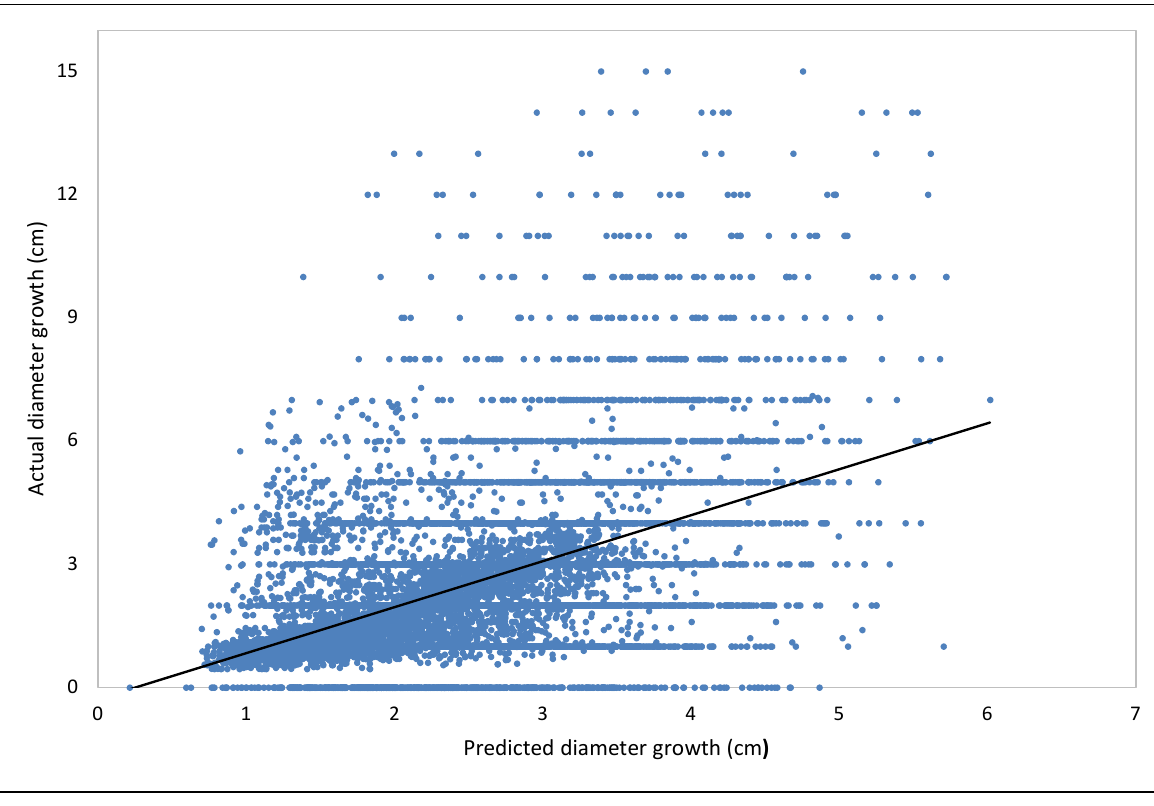
Figure 10. Relationship between predicted and actual diameter increment by mixed-effect regression (cm) affected by climate change. Table 9. Results of regression model analysis for diameter growth of trees under change climate.